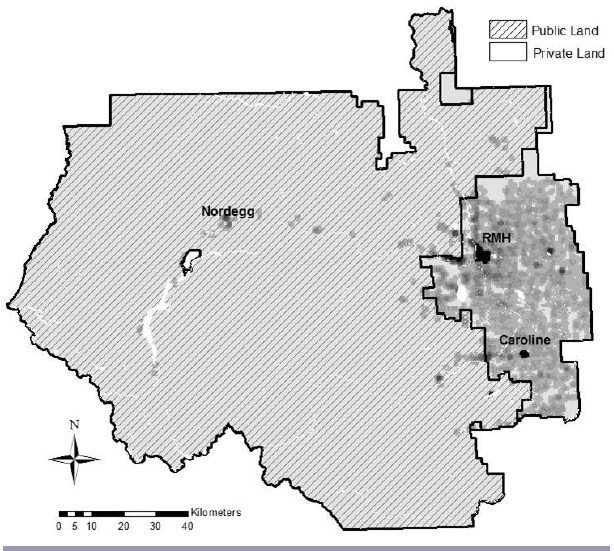
Fig. 1 . Map of Clearwater County depicting the gradient of human population density. The lightest grey areas have a density of < 1 buildling per km² while the darkest are > 200 buildings per km². Also shown is the divide between public and private land, lakes and rivers (white), and the three principal towns: Rocky Mountain House (RMH), Caroline, and